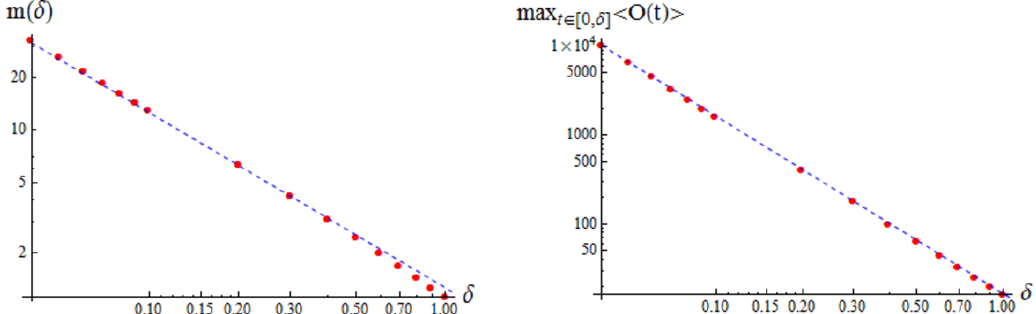
Figure 9 . Left: log-log plot of m ( (cid:14) ) (red dots) and the (cid:12)tting curve m ( (cid:14) ) / (cid:14) (cid:0) 1 (blue dashed) for a quench o(cid:11) the (cid:11) 0 = 1 pumping solution with interpolating function (5.1). Right: log-log plot of max hO (cid:30) ( t ) i (red dots) and the (cid:12)tting curve max t 2 [0 ;(cid:14) ] same quench process as in the left